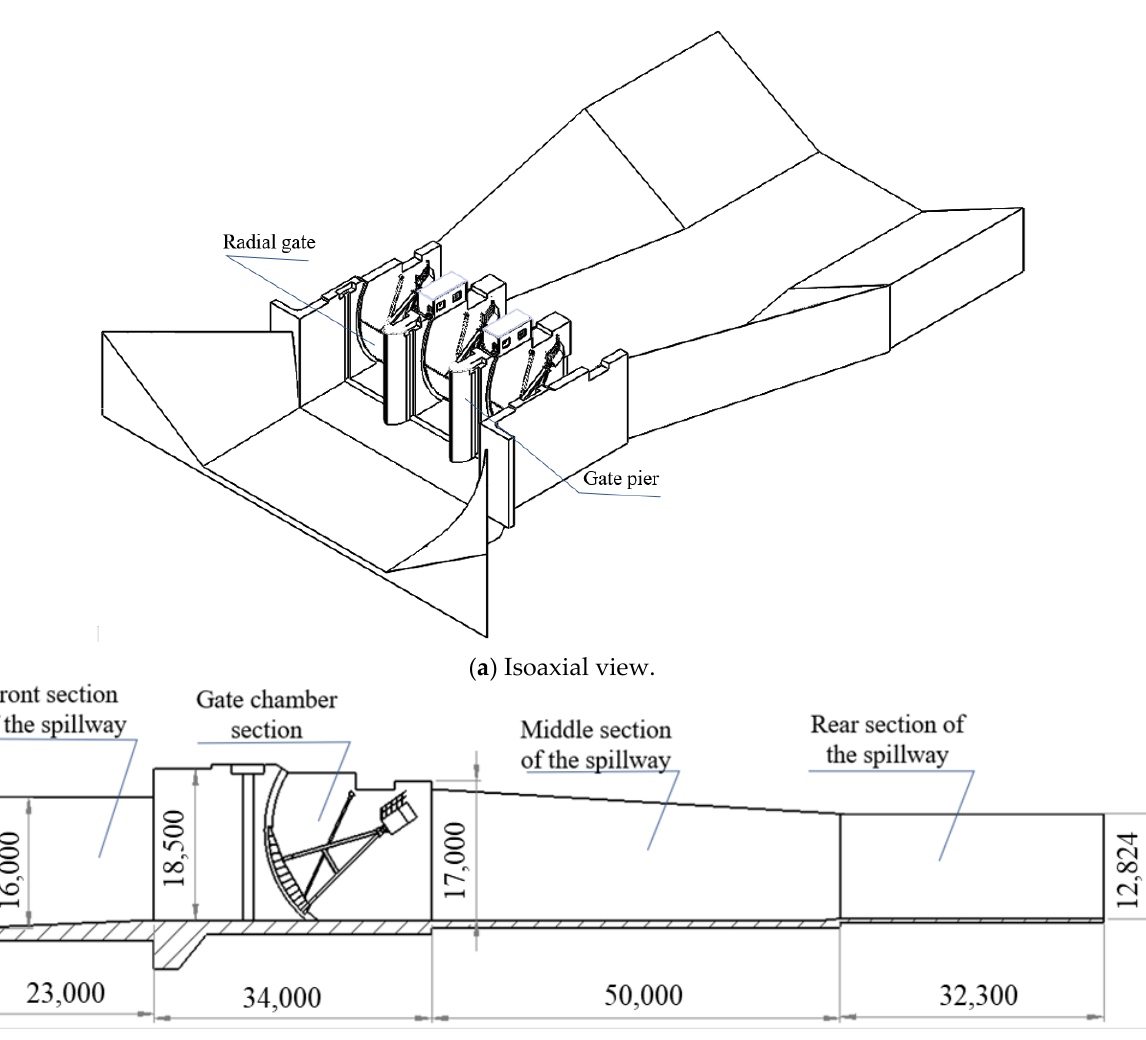
Figure 1. Spillway structure diagram.